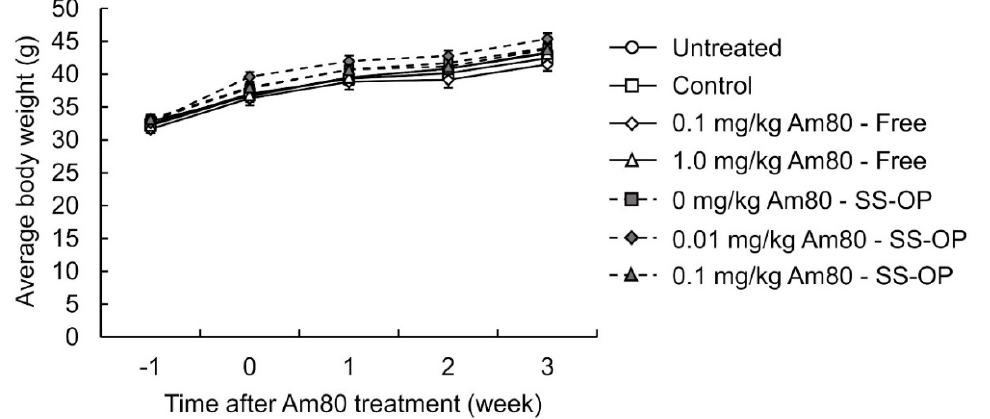
Figure 6. Effects of free Am80 and Am80-encapsulated SS-OP nanoparticles on the body weight decrease. Elastase-induced COPD model mice were treated with 0.1 and 1.0 mg/kg of free Am80 and 0.01 and 0.1 mg/kg of Am80-encapsulated SS-OP nanoparticles twice a week by pulmonary administration. The mean body weights measured at -1 (elastase administration point), 0, 1, 2, and 3 weeks after starting the administration of Am80 are shown. Data represent the mean ± S.E. (n = 5–7).